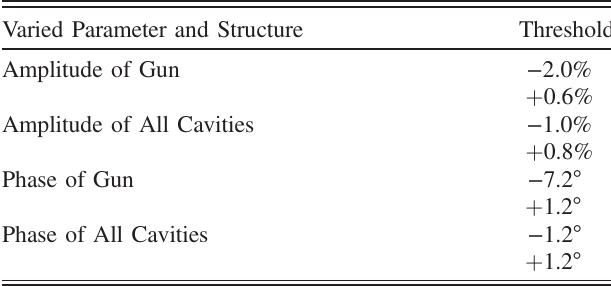
TABLE XIII. The amplitude and phase perturbation from design for each SRF structure at which some electron beam parameter changes ∼ 20% at the